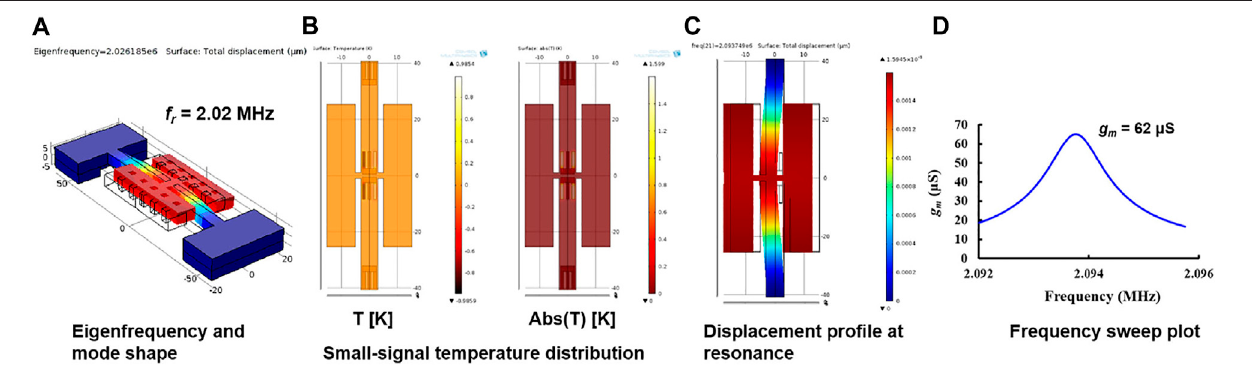
FIGURE 5 | FEM simulation of CCB showing (A) eigenfrequency of 2.02 MHz for the in-plane mode. (B) Small-signal temperature distribution for the differential drive and the average temperature change of 1.6 K, (C) a uniform displacement of 1.6 nm at resonance, and (D) transconductance ( g m ) of 62 µS at resonance for a frequency sweep study.